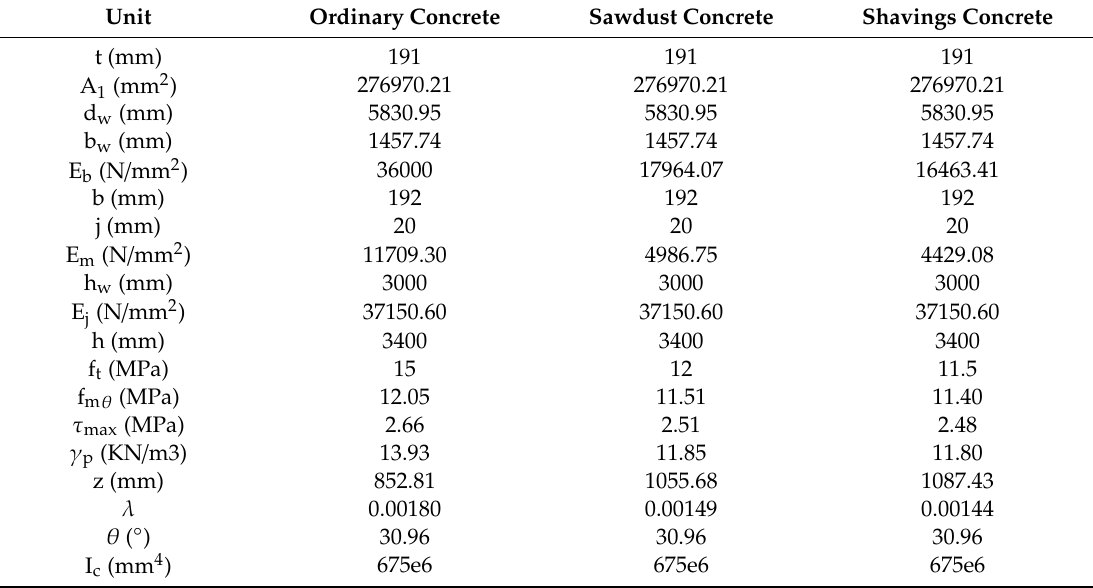
Table 7. Numerical values for geometric and mechanic parameters obtained in the laboratory.